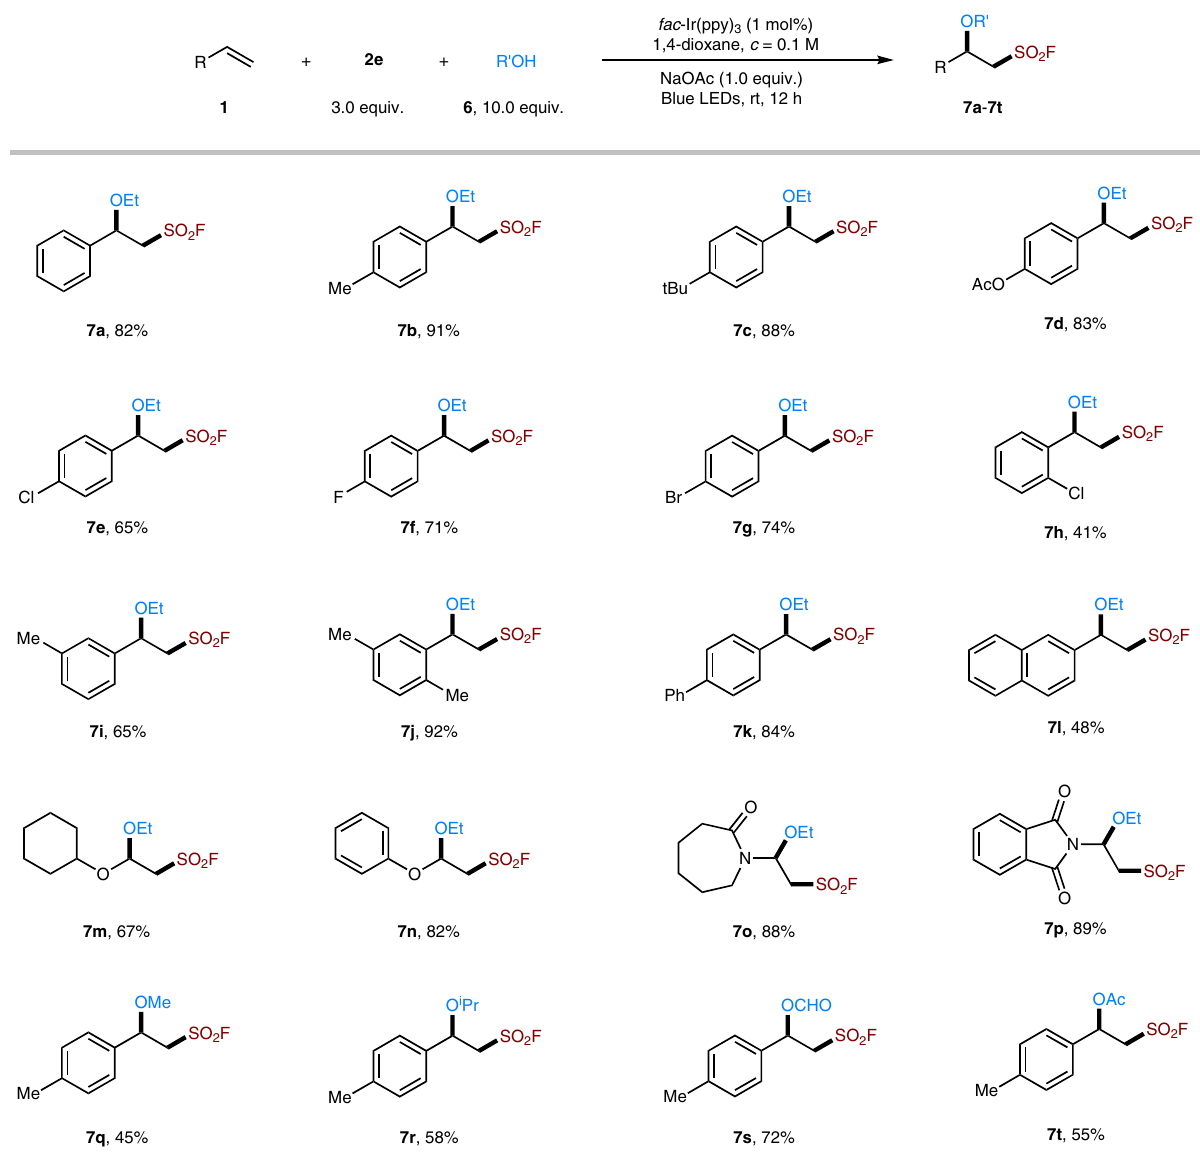
Fig. 5 Photoredox alkoxy- fl uorosulfonyl difunctionalization of ole fi ns. The reactions were performed with alkene (0.1 mmol), 2e (0.3 mmol), EtOH (1 mmol), fac -Ir(ppy) 3 (1 mol%), NaOAc (0.1 mmol), and 1,4-dioxane (1 mL) under the irradiation of 6W blue